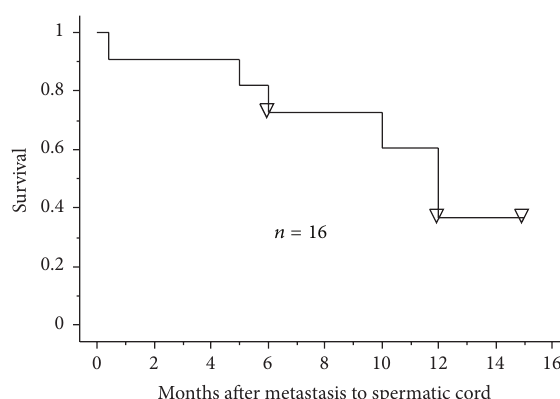
Figure 4: Survival after metastasis to the spermatic cord in the identified cases since